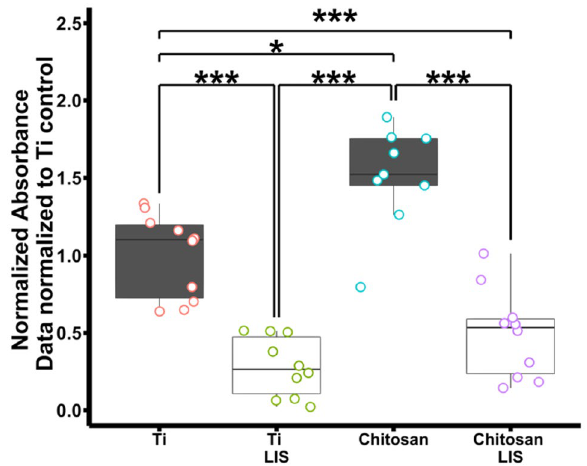
Figure 4. Crystal Violet Evaluation of S. aureus Biofilm Formation. Normalized crystal violet absorbance after biofilm growth using MRSA MW2 strain on titanium (Ti) [ n = 10], liquid-infused titanium (Ti-LIS) [ n = 10], chitosan-coated titanium (Chitosan) [ n = 9], and biofunctional chitosan liquid-infused titanium (Chitosan- LIS) [ n = 10]. The data were normalized by dividing all data points by the mean of the titanium control samples (Ti). Whiskers span the first quartile and fourth quartile range. Statistical significance was tested using Kruskal Wallis, followed by a Conover’s test to compare the mean rank-sum. The statistical significance is annotation as ‘*’ for P < 0.05, ‘**’ for P < 0.01 and ‘***’ for P <